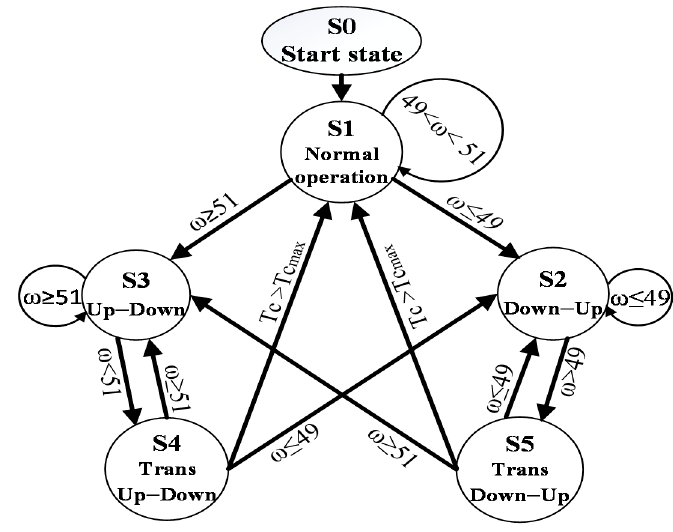
Figure 6. Proposed finite state machine (FSM) for the SOGI-FLL.